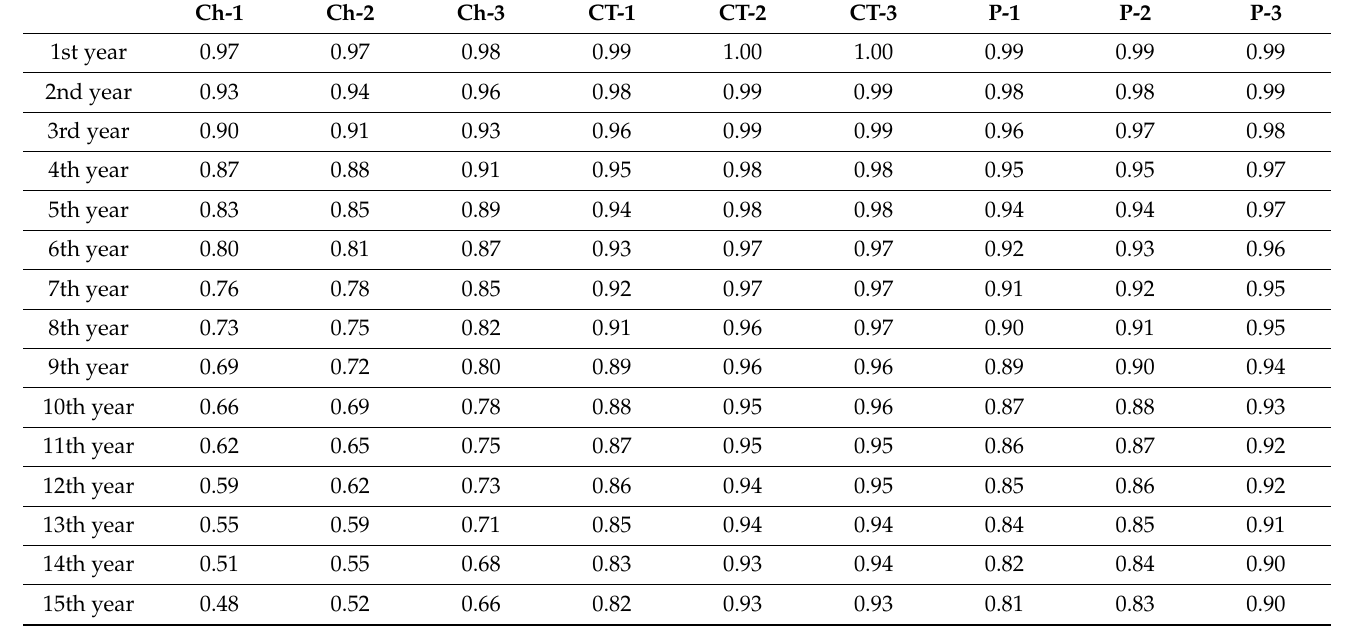
Table 9. Performance degradation rate of each device (Unit: [-]).